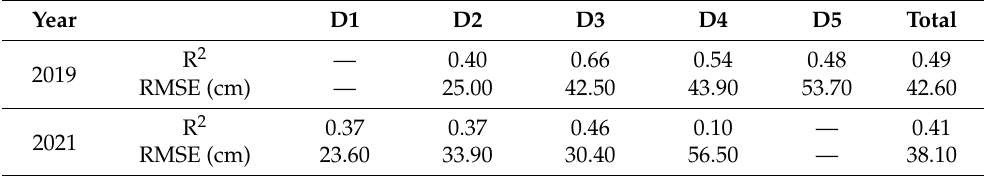
Figure 9. EH estimation at di ff erent planting densities at plot scale for fi lling period for DLS data ( a ) in 2019 and ( b ) in 2021. Table 7. R 2 and RMSE of EH of different densities from DLS data in 2019 and 2021. Table 7. R 2 and RMSE of EH of di ff erent densities from DLS data in 2019 and 2021.